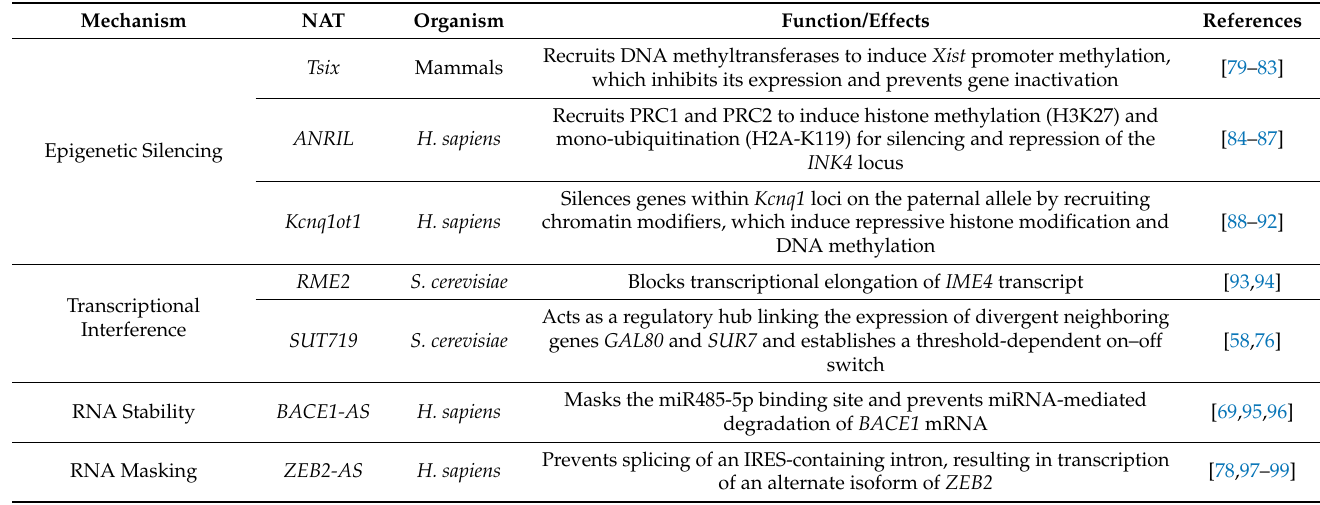
Table 1. NATs in eukaryotic